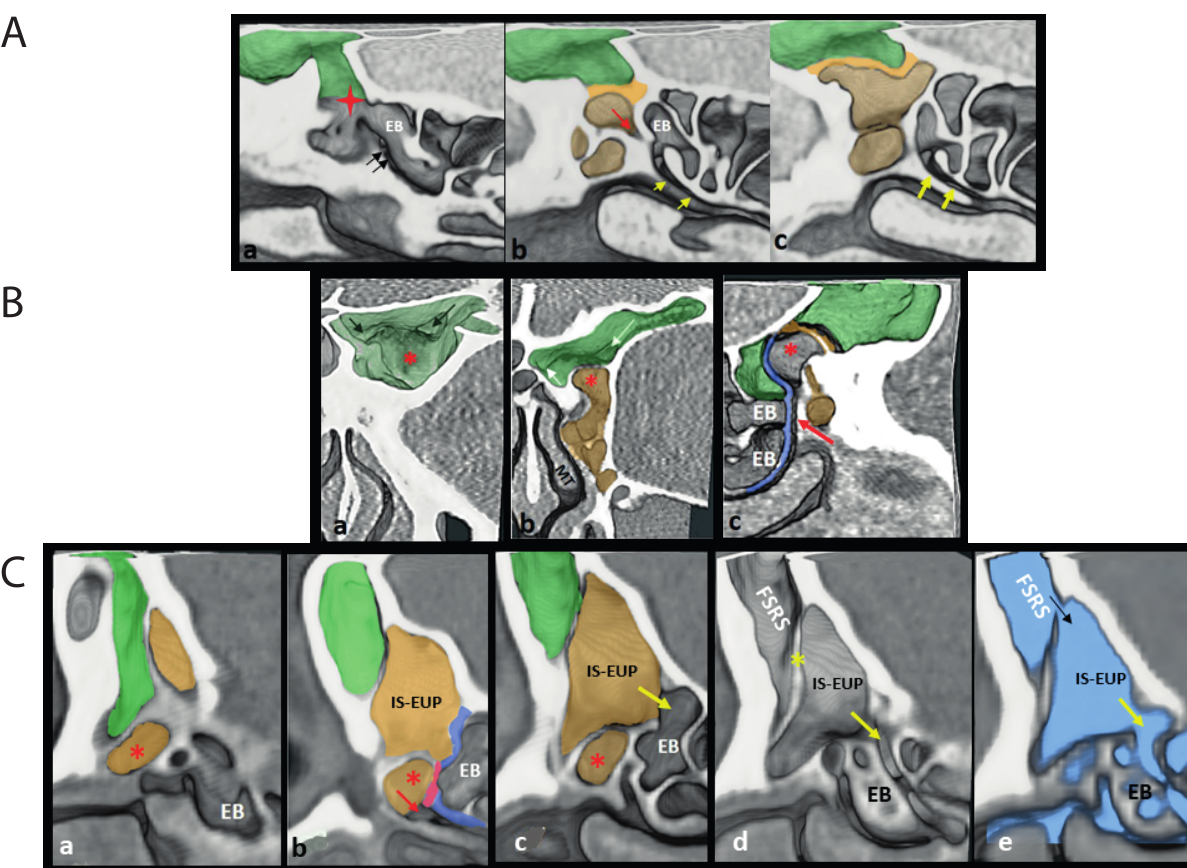
Figure 3. Expansion of IS-EUP into FR &